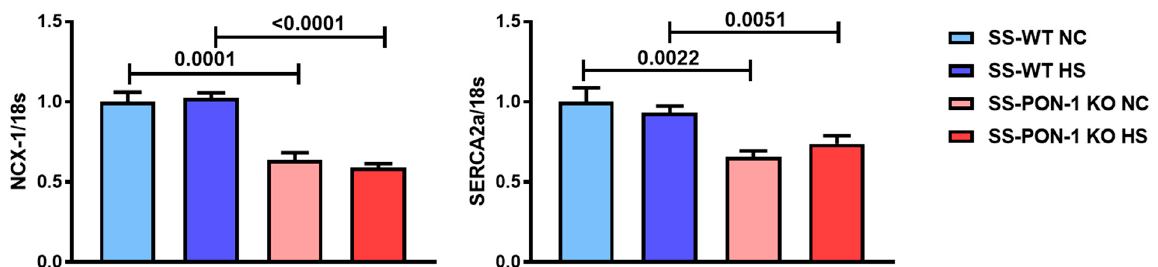
Figure 6. Targeted mutation of paraoxonase-1 contributes to decrease in left ventricular function gene expression in a hypertensive renal disease model. SS-PON-1 KO HS rats showed significant decrease in sarcoplasmic reticulum calcium ATPase 2A (atp2a2) and sodium–calcium exchanger (SLC8A1) gene expression compared to SS-WT rats following 5 weeks of 8% high-salt diet ( N = 8). Data are presented as the mean ± standard error of the mean. One-way ANOVA and post hoc multiple comparison tests were used to assess statistically significant differences between the groups.